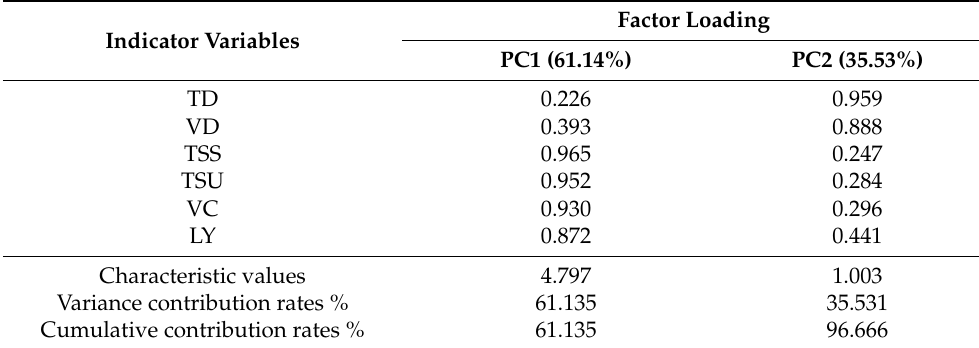
Table 7. Factor loadings and variance contribution rates of the principal